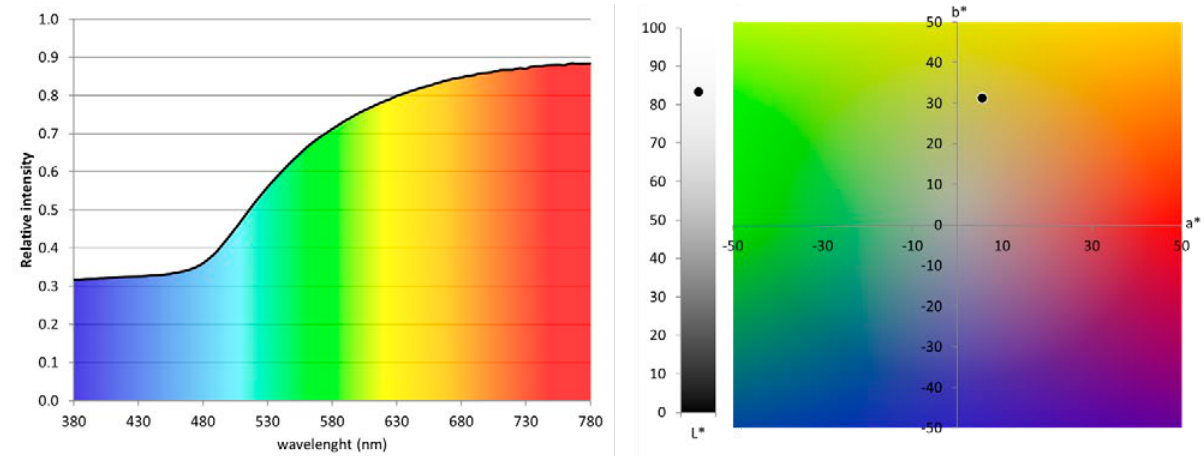
Figure 3. Measured reflectance spectrum (left) and the calculated colorimetric coordinates (right) of a gold